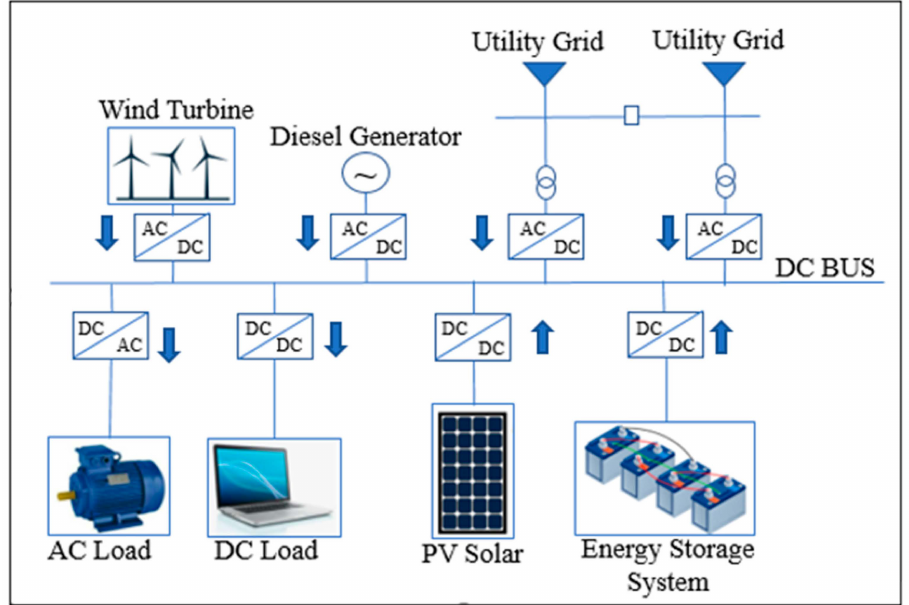
Figure 4. Direct current (DC) MG